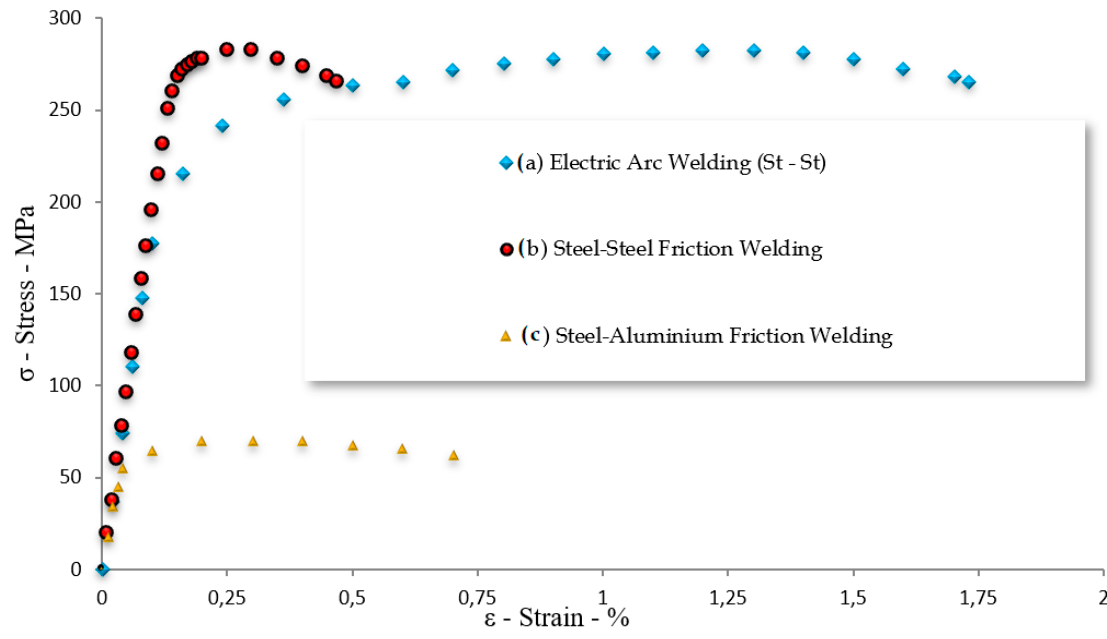
Figure 6. Tensile test of specimens: ( a ) Arc welded material and ( b , c ) friction welded specimen.